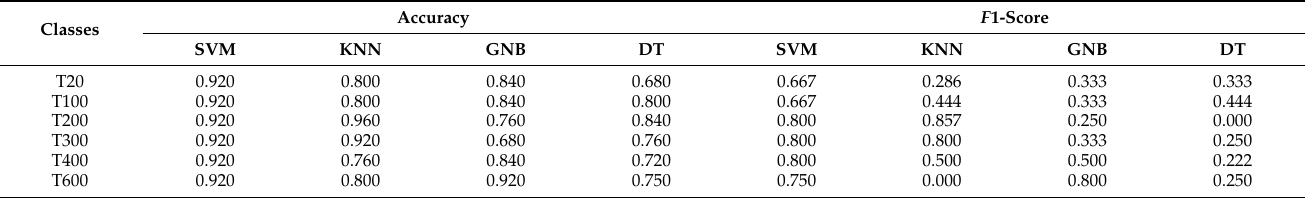
Table 4. Accuracy and F 1-score of different ML algorithms in classifying the UPV signals using sampling rate equal to 125 kHz and time window equal to 5